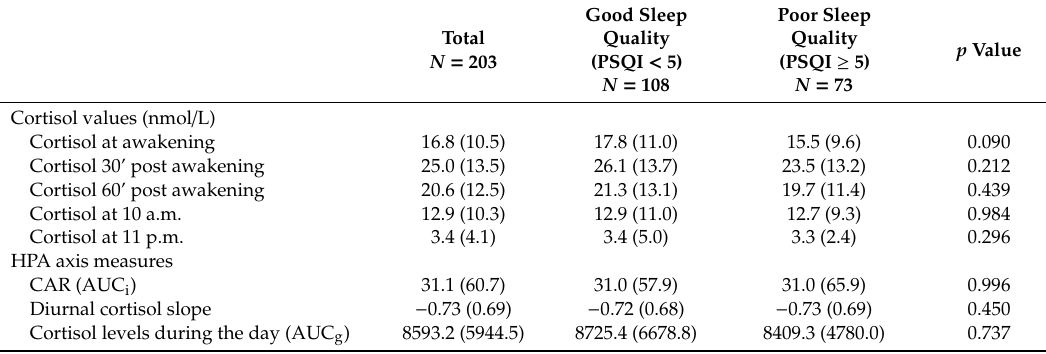
Table 2. HPA axis measures by sleep quality groups.